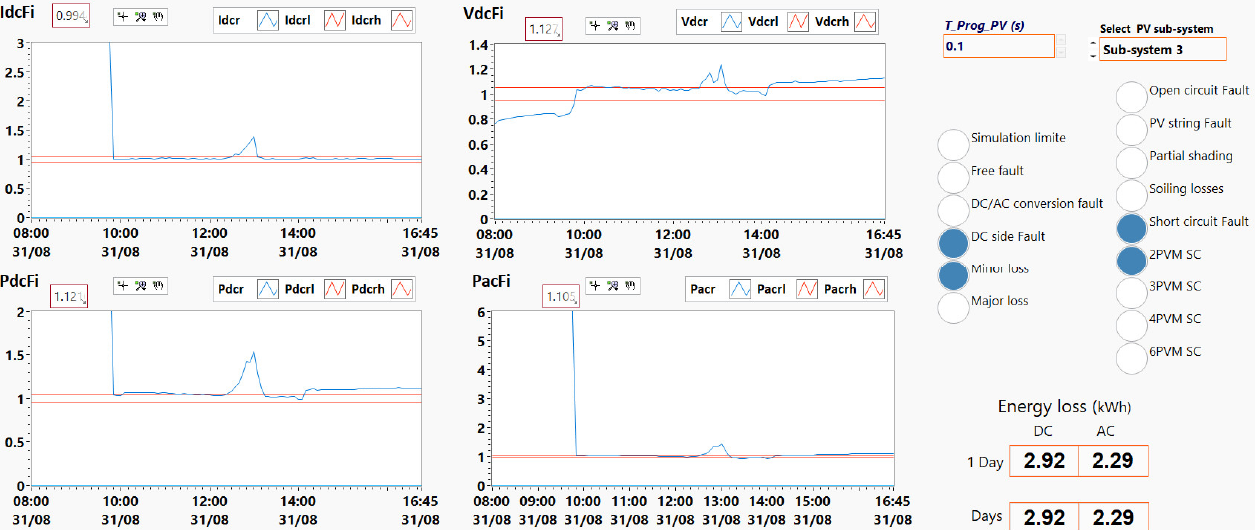
Figure 31. Identification of soiling losses caused by dust accumulation on the PV subarray 1.